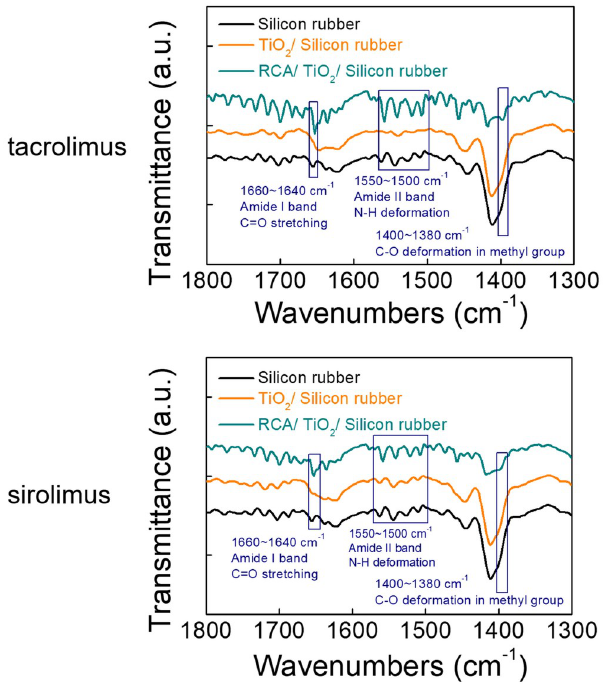
Fig 3. Transmittance of the drug-coated silicone